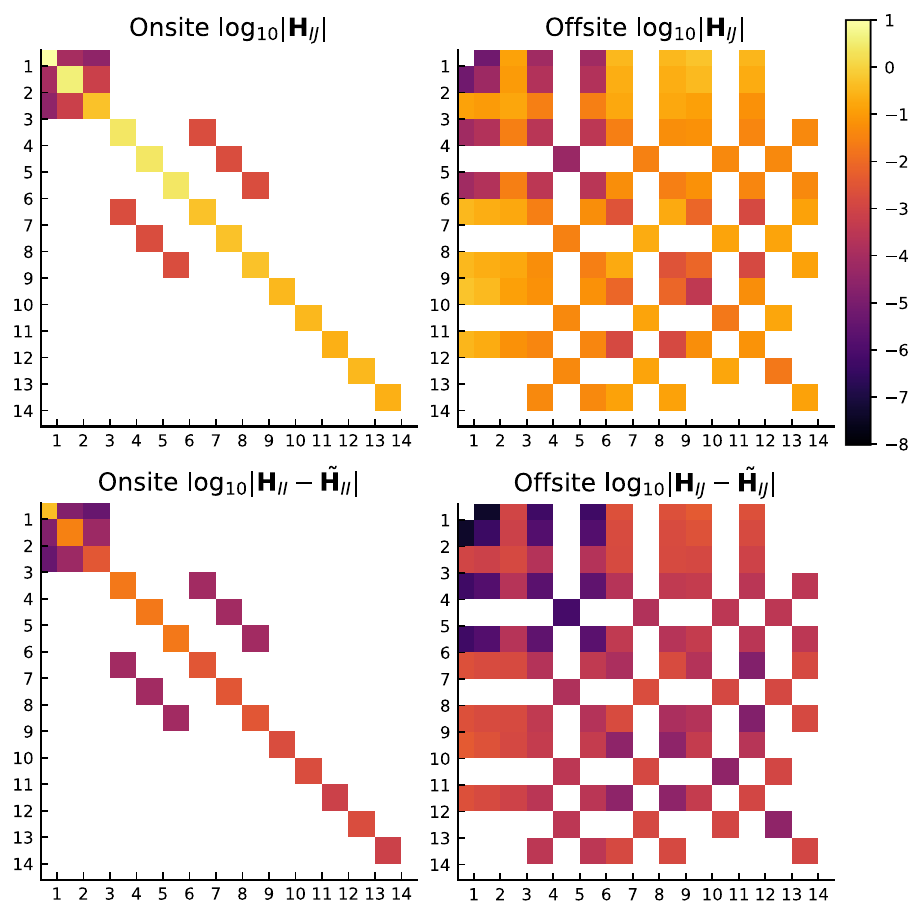
Fig. 4 Accuracy of predicted Hamiltonian blocks for the FCC crystal. Magnitudes (above) and errors (below) for onsite (left) and offsite (right) ~ H for prediction on the FCC ground state unit cell (not included in the training